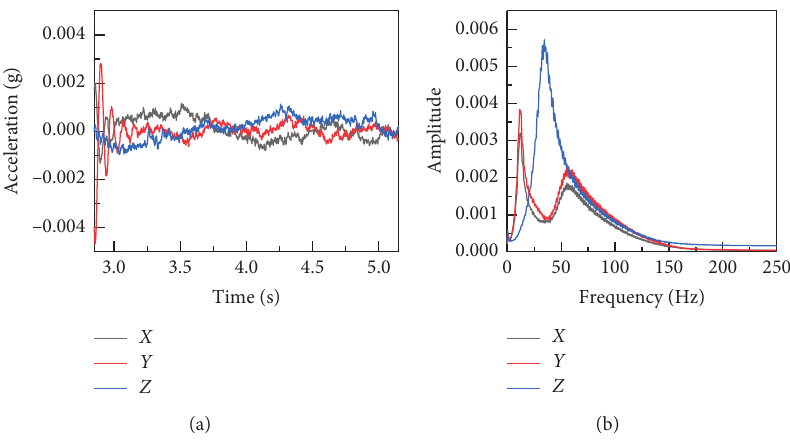
Figure 6: Monitoring data of measurement point one: (a) time-domain signals of vibration; (b) frequency-domain signal of vibration.